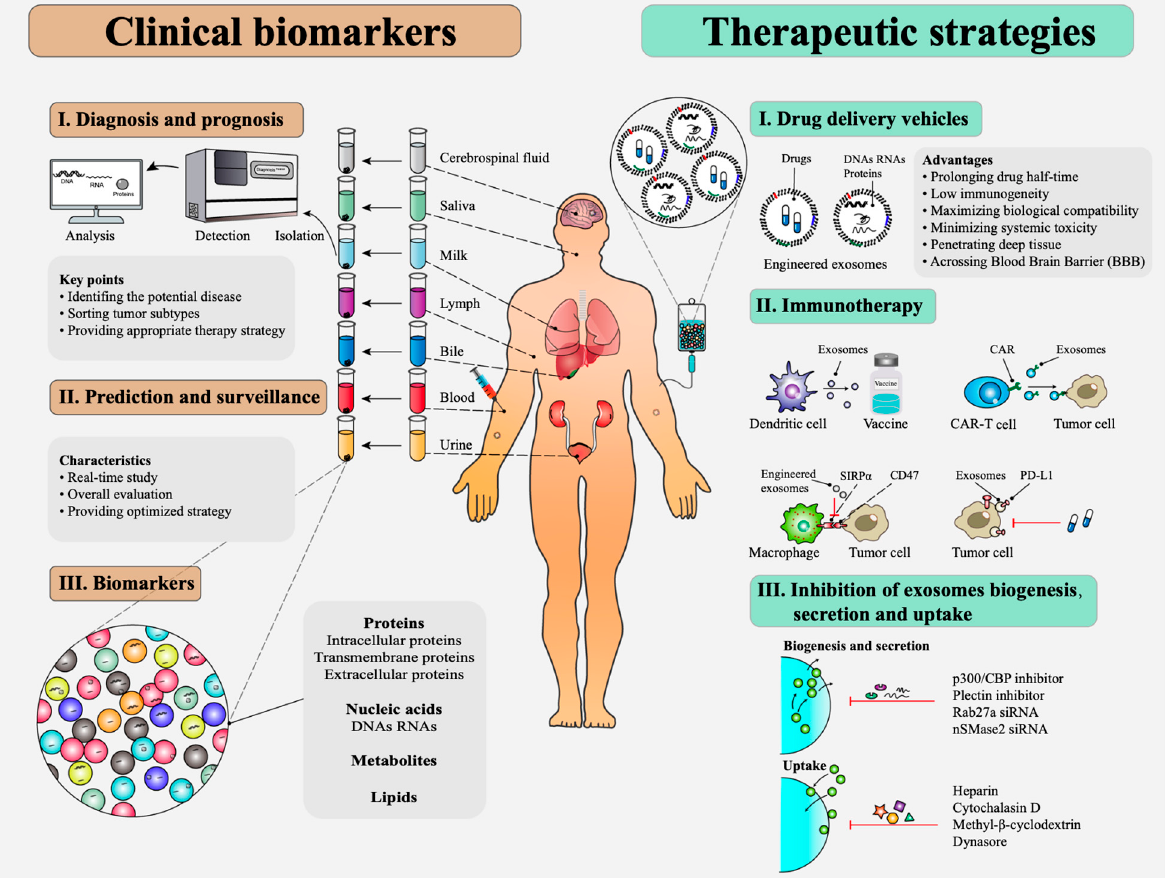
Figure 1. Key applications of exosomes. Reprinted with permission from Zhu, L. et al., 2000 [7].